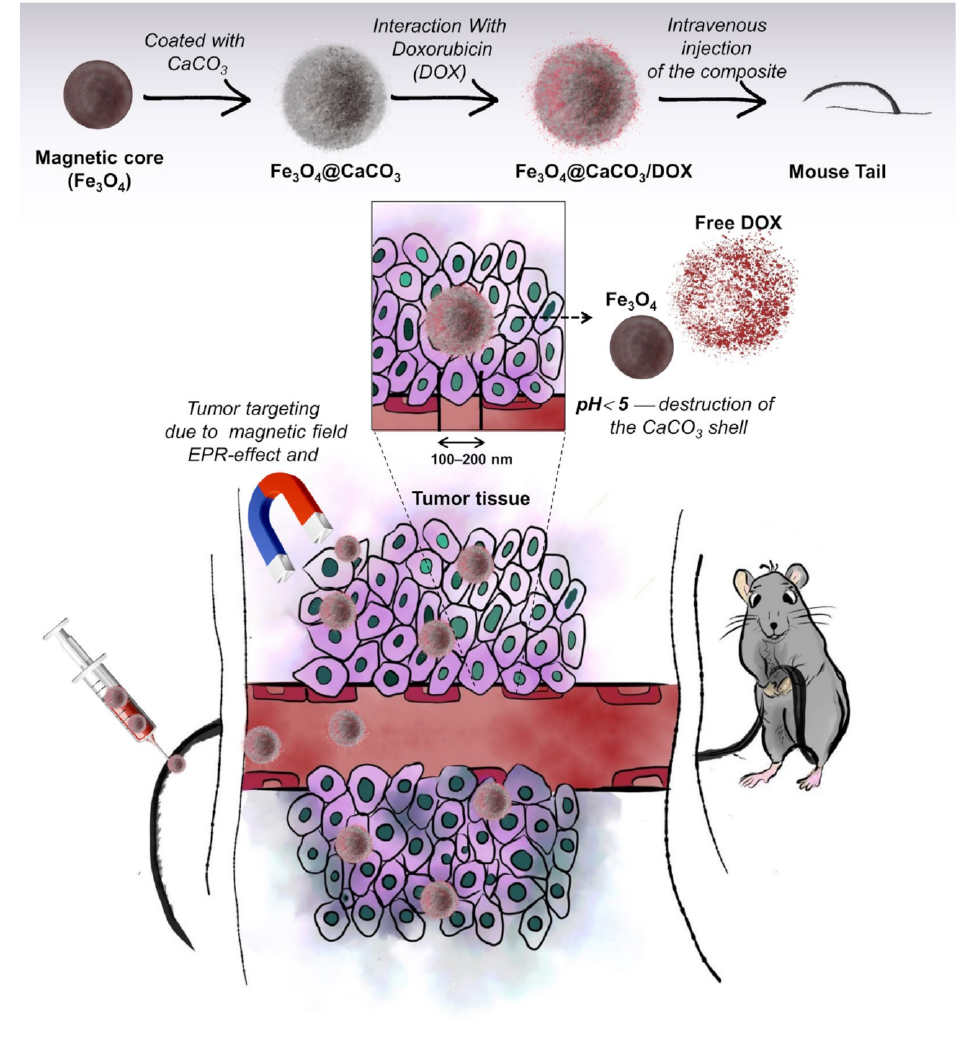
Figure 1. Synthesis of Fe 3 O 4 @CaCO 3 and doxorubicin-loaded (Fe 3 O 4 @CaCO 3 /DOX) nanocompos- ites and their distribution through the bloodstream to the